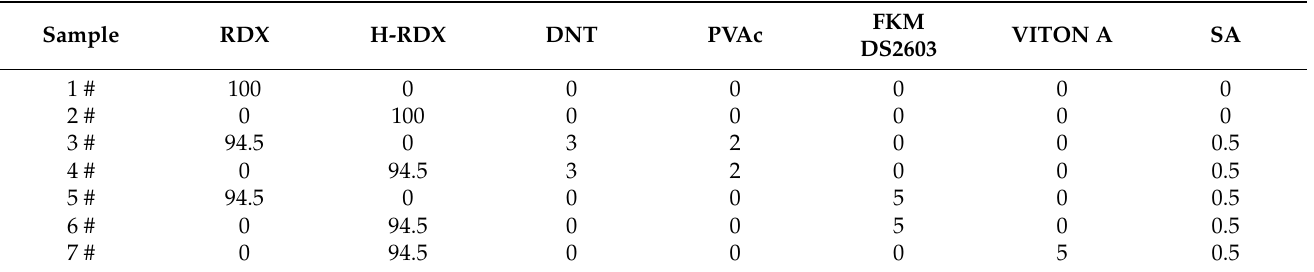
Table 1. Formulations of PBX with different RDX